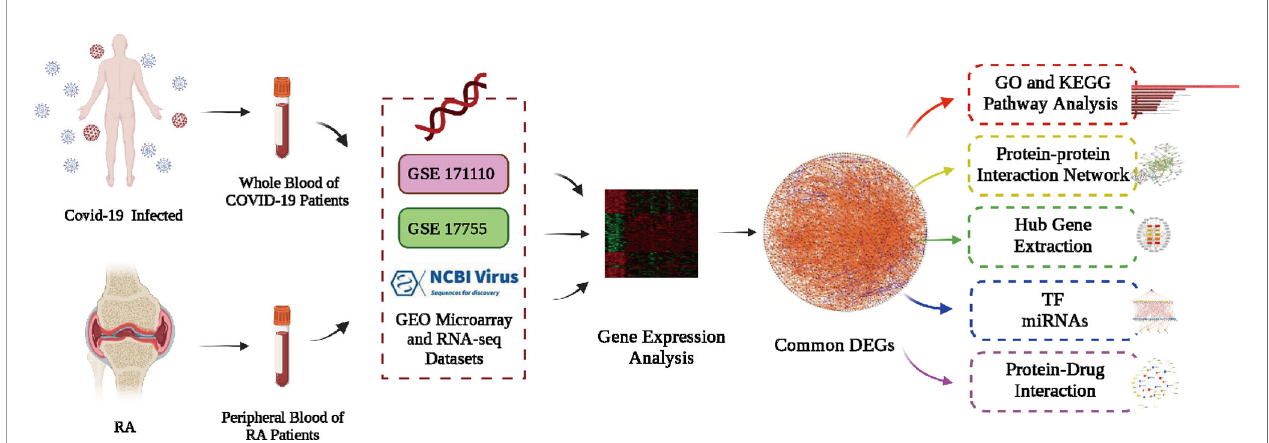
FIGURE 1 | Principle scheme diagram of the whole work fl ow of this